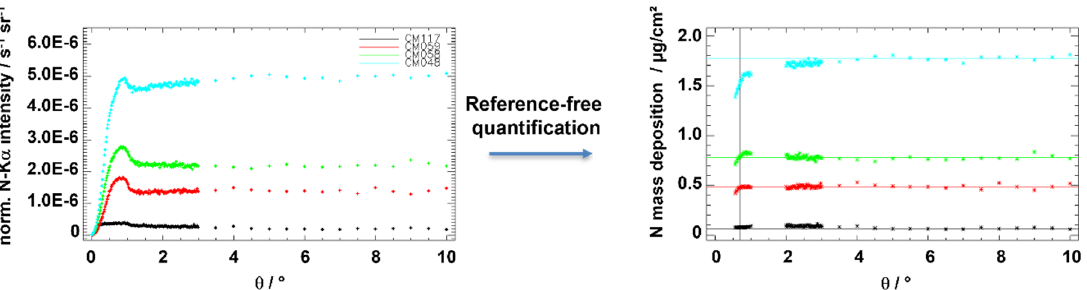
Figure 3. Experimentally revealed fluorescence intensities and deduced elemental mass depositions of different nitrogen-containing environmental